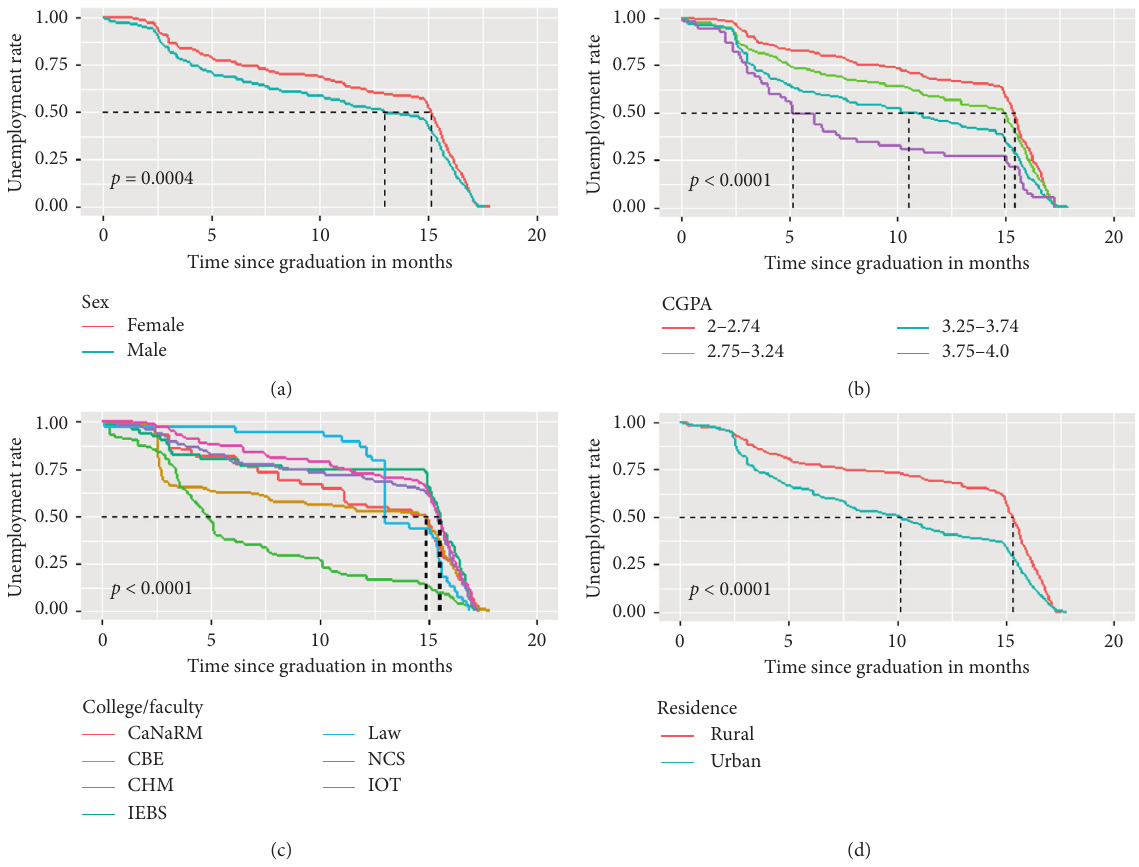
Figure 2: Kaplan–Meier curve for the waiting time for the first employment by gender, college, CGPA, region, and residence of